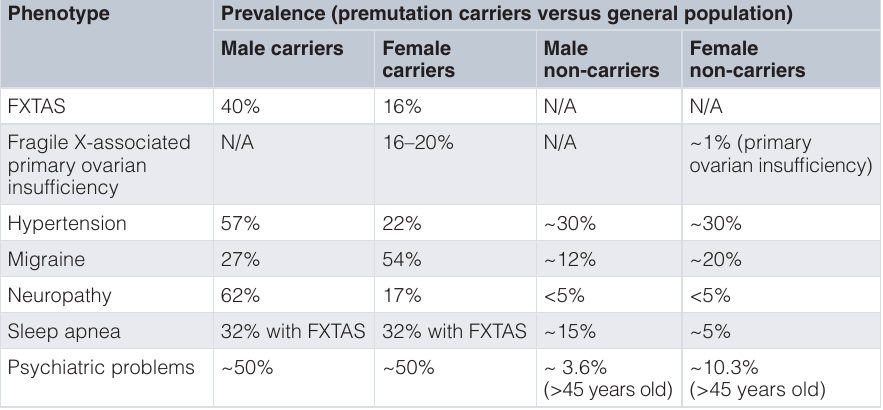
Table 2. Clinical involvement associated with the premutation.